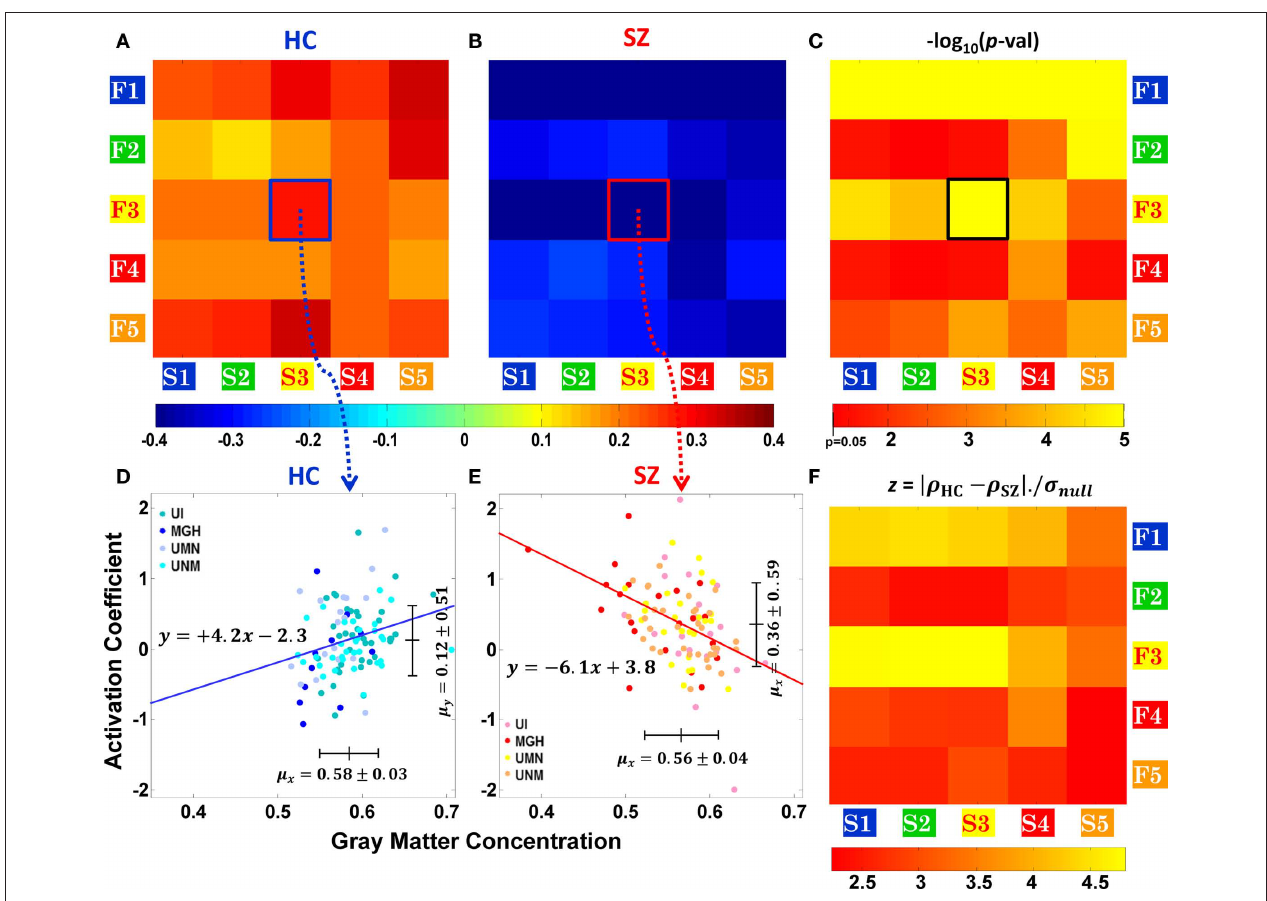
significance of correlation differences are presented. Scatter plots of Structural cluster S3 and functional cluster F3 are presented for HC and SZ in (D) and (e) . Data points are presented in different colors corresponding to the site where the scan was performed. In (F) we compare the significance of the correlation difference result with the variance of the null distribution as